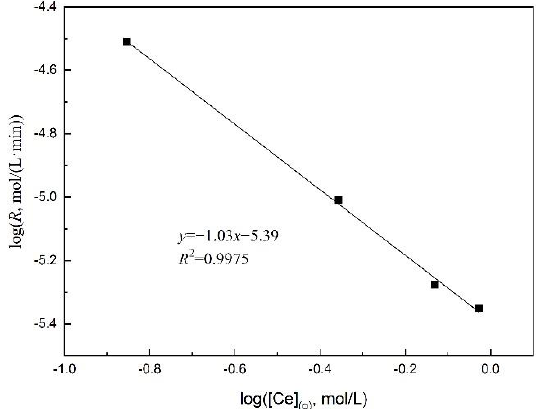
Figure 6. Effect of free extractant concentration in organic phase on the stripping rate (experimental conditions: Ce 4+ concentration in organic phase 0.02 mol/L, HCl concentration in stripping agent 6.0 mol/L, c (H 2 O 2 ) (a) : c (Ce) (o) 2:1, temperature 25 °C and stirring speed 300 r/min).